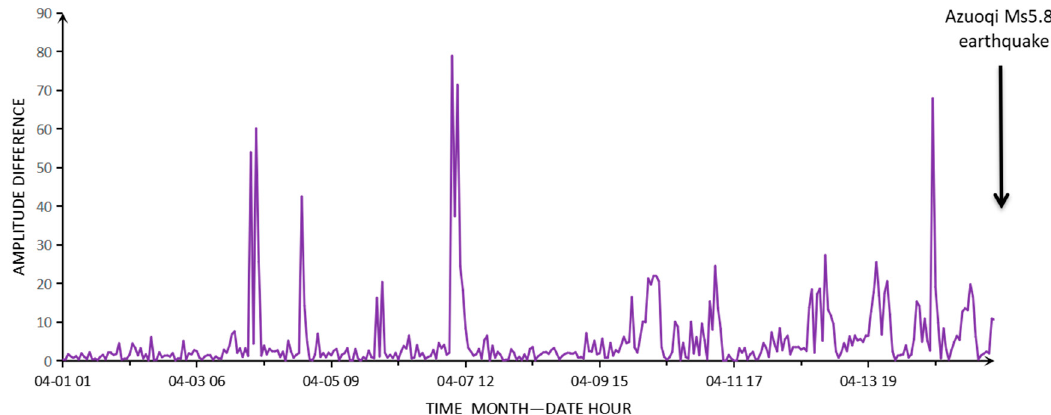
Figure 7. WUH and DSM 1–15 April 2015 low-frequency signal.